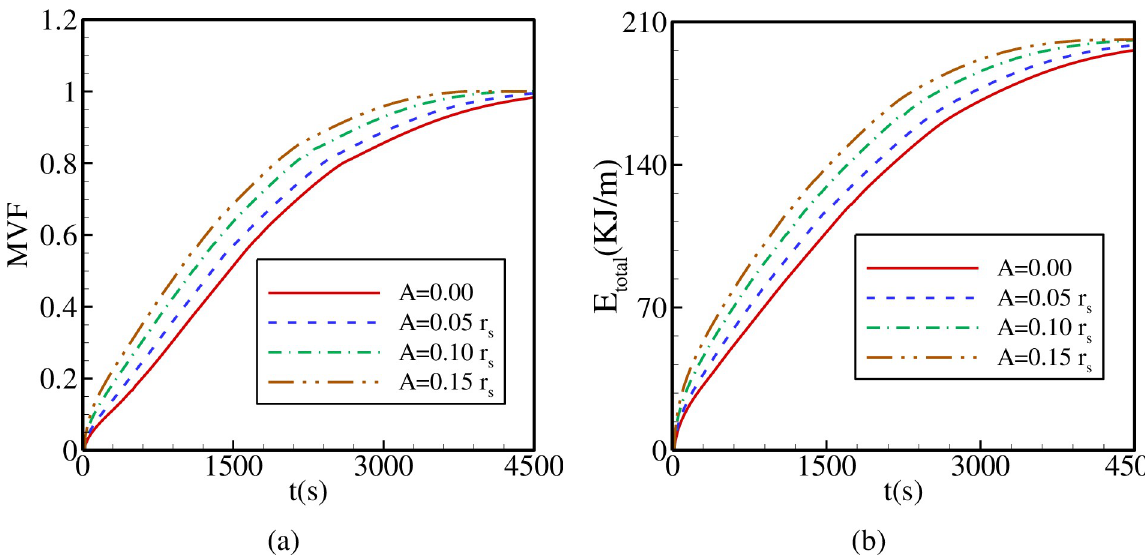
Fig 15. The effects of the sinusoidal amplitude of the quasi-petal heat pipe on (a): the melt volume fraction (MVF); (b): the total energy stored (E total ) when r d = 0.6 r s , Λ = 5, and η = π /4.